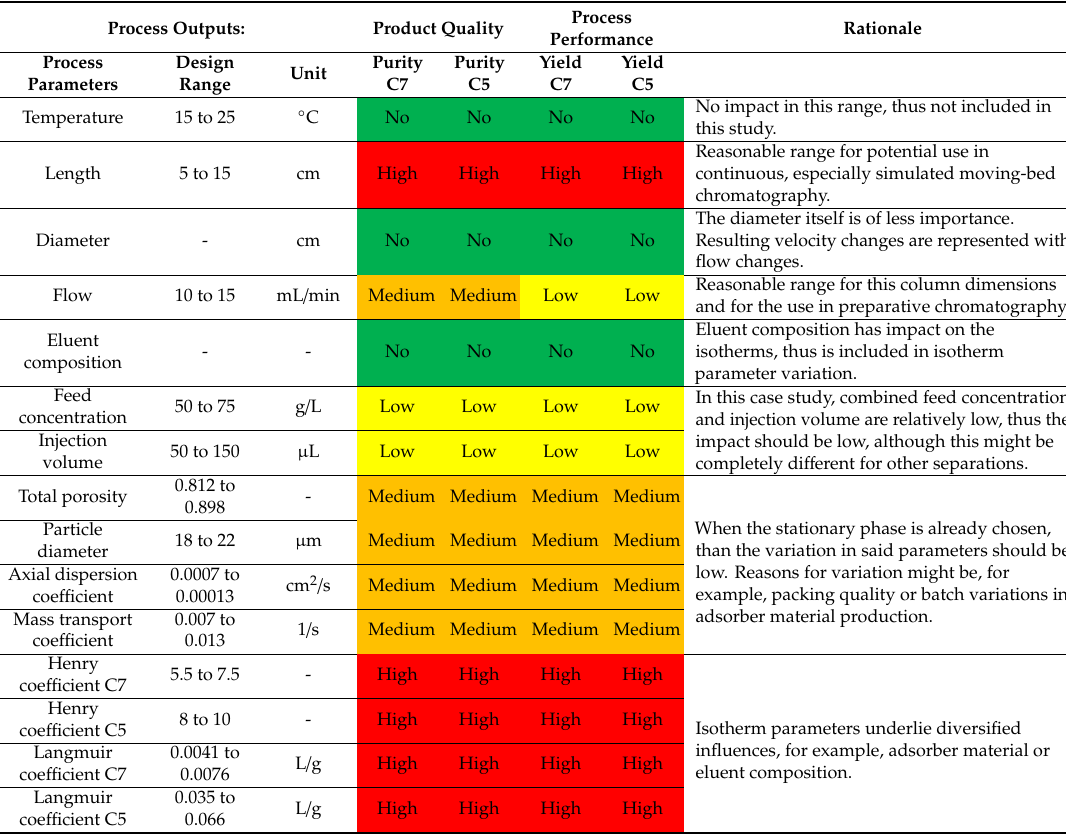
Table 3. Process and model parameters, their design range and the expected impact on cyclopentanone and cycloheptanone purity and yield. Green—no impact; yellow—low impact; orange—medium impact; red—high impact.